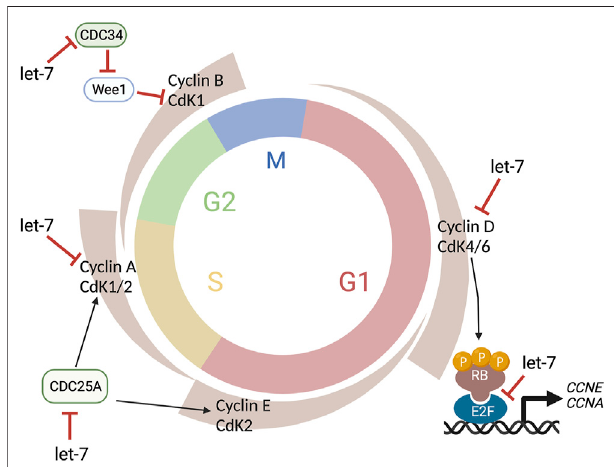
FIGURE 4 | Let-7 regulation of the cell cycle. Let-7 regulates the cell cycle kinetics by both promoting cell cycle exit and lengthening distinct phases. Let-7 targets Cyclin D, CDK4, and CDK6, CDC25A, Cyclin A, and CDC34, affecting the G1/S, S/G2, and G2/M transitions, respectively. This fi gure was created with